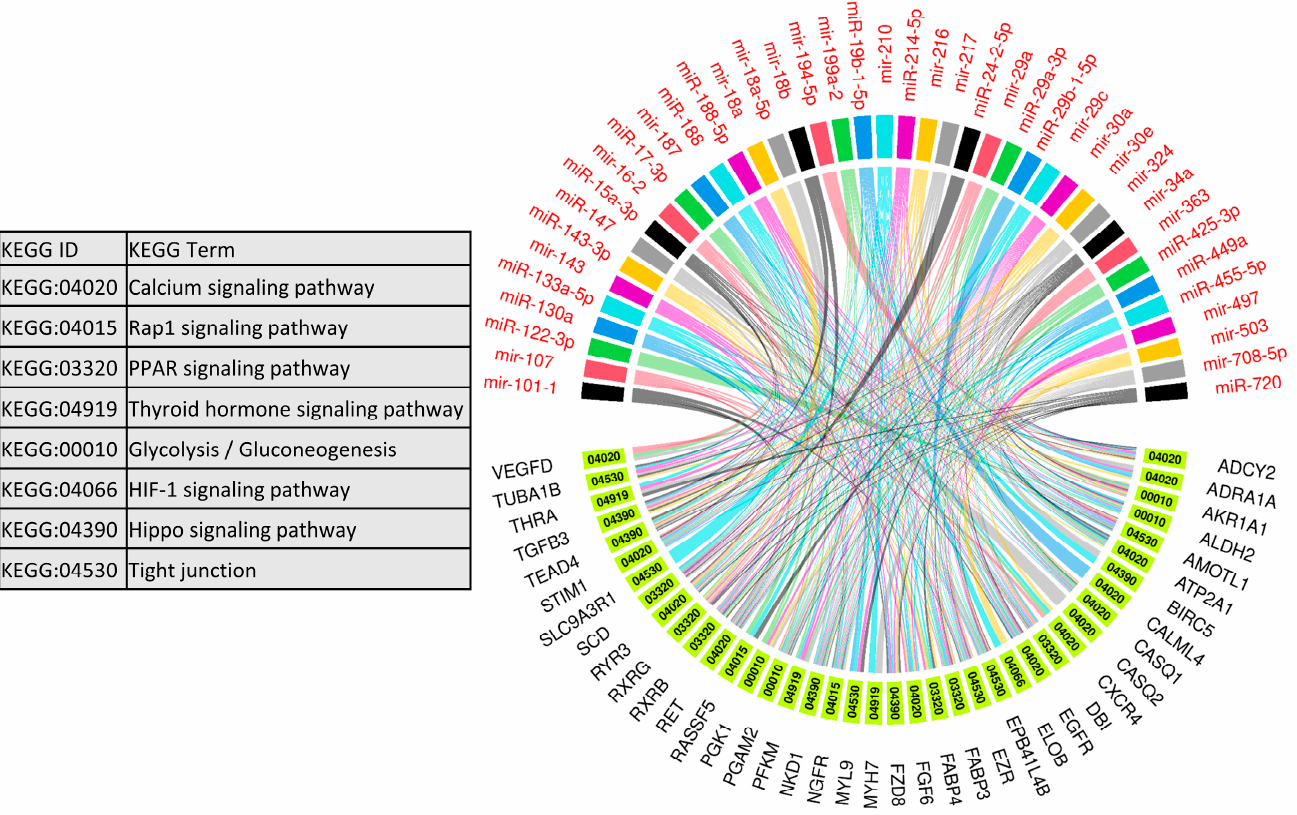
Figure 6. Enrichment analysis of downregulated genes, which are negatively correlated to and targeted by upregulated miRNAs, in KEGG pathways derived using the ClueGO (version 2.5.1) and Cluepedia (version 1.5.7) plugin in Cytoscape (version 3.8.2) environment. A complete list of KEGG pathways enriched by downregulated genes is provided in Table S3.